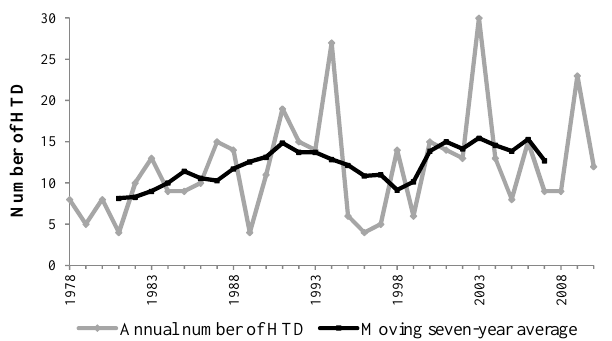
Fig. 2. Annual number of high temperature days (HTDs) (light grey Figure 2. Annual number of high temperature days (HTD) (light grey line) in Aragón from2 line) in Arag´on from 1978 to 2010 and moving seven-year average 1978 to 2010 and moving seven-year average (black line) from 1981 to 2007.3 (black line) from 1981 to 2007.